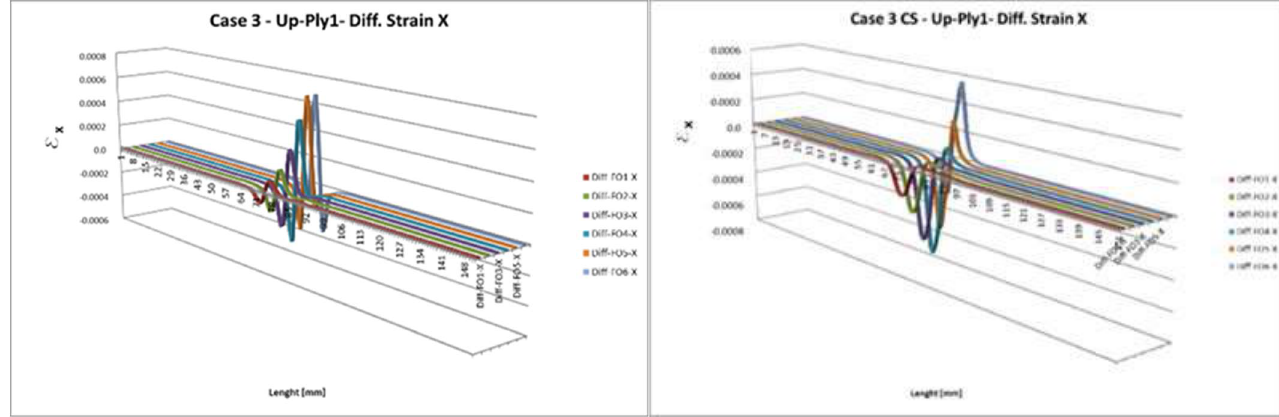
Figure 5. A 3D representation of Figure 4a ( left ), and 4b ( right ).